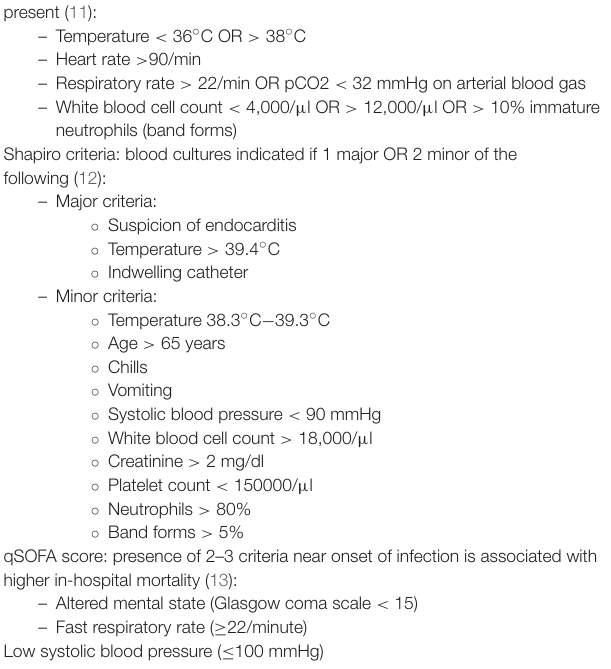
features of infections acquired in the hospital were very similar to those acquired in other types of healthcare facilities (65–68). A presents itself more than 48 h after the patient has been admitted